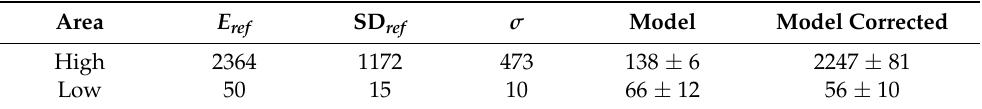
Table 9. Reference radon flux value E ref and standard deviation SD ref obtained from participant results according to ISO 13528:2015, including the parameter σ = 0.2 · E ref . “Model” indicates the prediction proposed by Kartsens et al. (2015) for the month of October and “Model Corrected” indicates the prediction adjusted considering the experimental values measured for radium in soil content. Values are expressed in Bq m − 2 h − 1